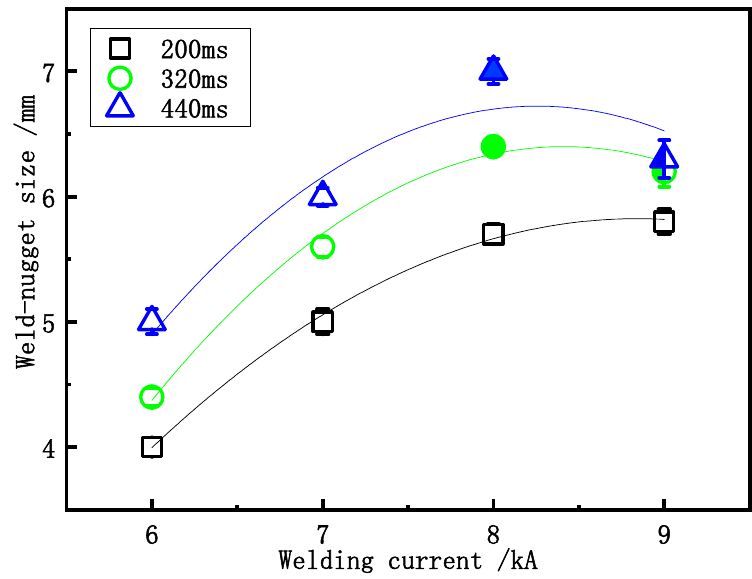
Figure 4. Effects of welding current and welding time on the weld nugget size.